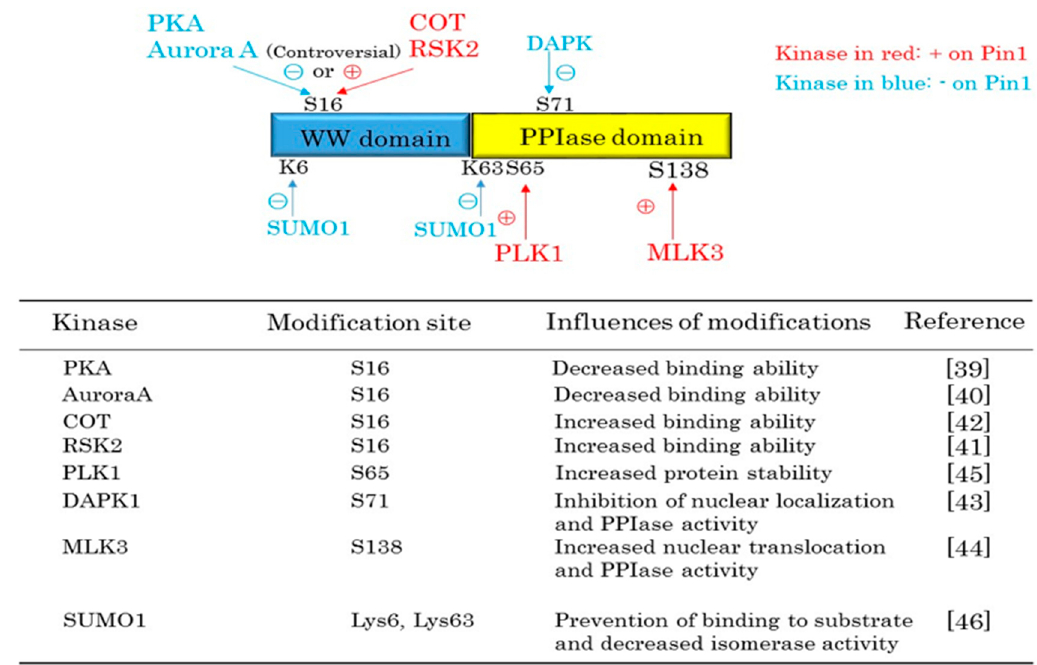
Figure 2. Pin1 functions are regulated by post-translational modifications. Some kinases phosphorylate Pin1 at Ser16 and may change the affinity of Pin1 for its substrates. However, the latter idea remains controversial. Pin1 phosphorylation by PLK1 and MLK3 upregulates the functions of Pin1 (shown as ⊕ ), while modifications by DAPK1 or SUMO1 downregulate Pin1 functions (shown as ○ - ).